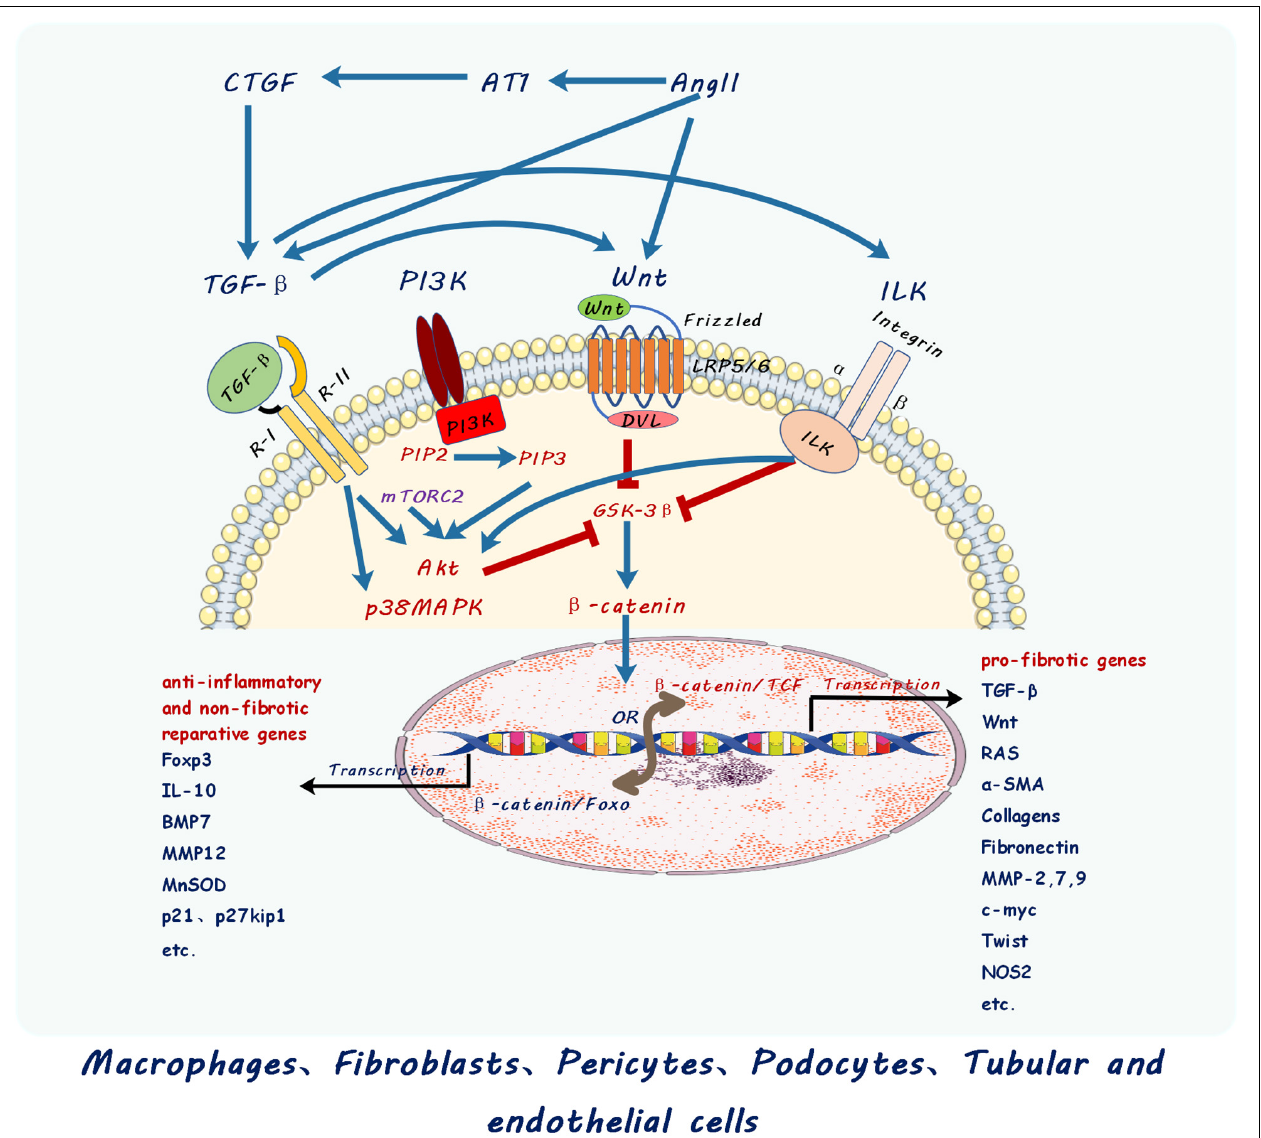
FIGURE 3 | Schematic diagram showing cross-talk between different signaling pathways including those of transforming growth factor beta (TGF- β ), Wingless and Int-1 (Wnts), Renin Angiotensin System (RAS), Integrin linked kinases (ILK), connective tissue growth factor (CTGF), and PI3K–mTOR. Multiple signaling pathways cross-talk and converge at β -catenin nuclear translocation and binding with different transcription factors to activate different target genes in macrophage and kidney cells described. PI3K, Phosphatidylinositol 3 kinase; Akt, Ak strain protein kinase B; mTOR, mammalian target of rapamycin; PIP2, phosphatidylinositol (4,5)-trisphosphate; PIP3, phosphatidylinositol (3,4,5)-trisphosphate; mTORC2, mTOR complex 2 including mTOR, Rictor, G β L, Sin1, PRR5/Protor-1, and DEPTOR; Ang II, Angiotensin II; AT1, Angiotensin receptor